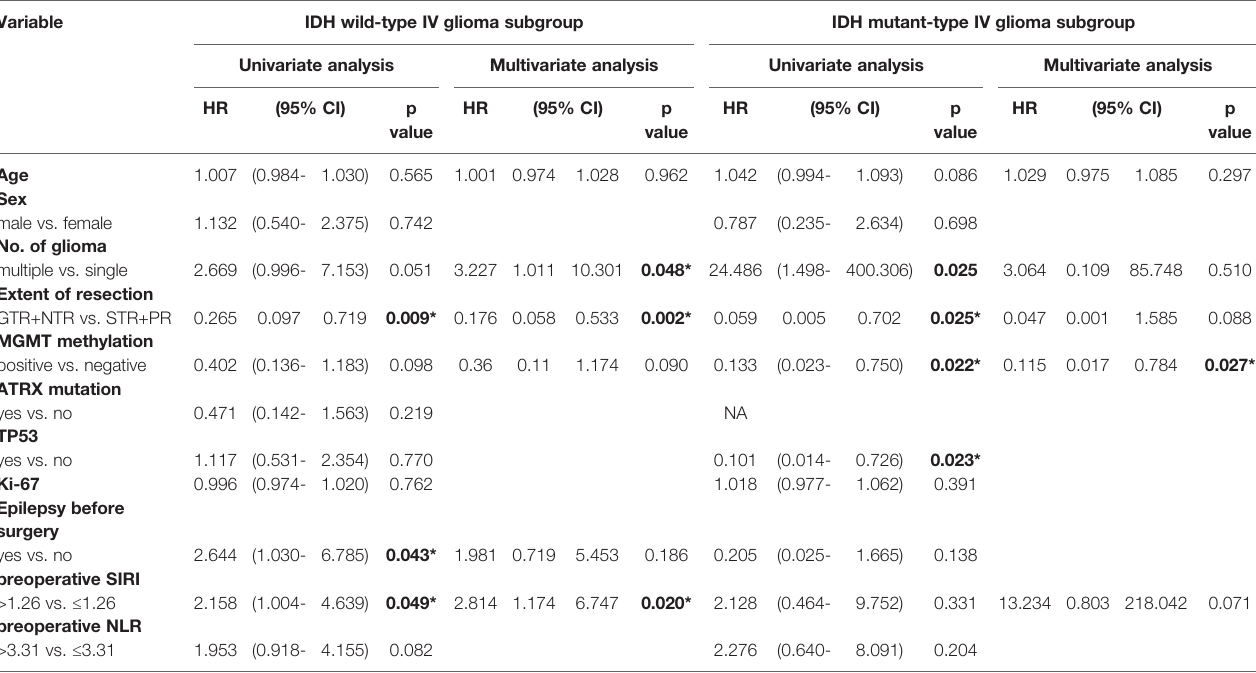
TABLE 4 | Univariate and multivariate cox regression analyses for overall survival in IDH wild-type IV glioma subgroup and IDH mutant-type IV glioma